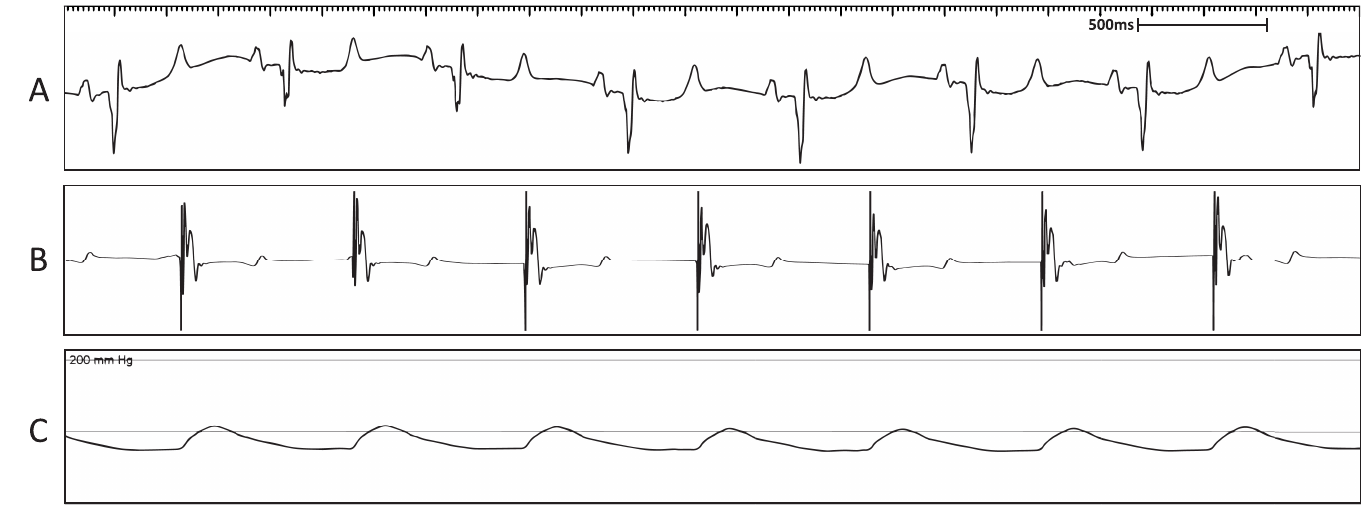
Fig 4. Representative surface ECG recordings during the pacemaker implantation to confirm lead placement. (A) Surface ECG depicting normal sinus rhythm under anaesthesia. (B) Surface ECG depicting paced rhythm during pacemaker diagnostics. (C) Mean arterial pressure trace indicating maintenance of blood pressure throughout the